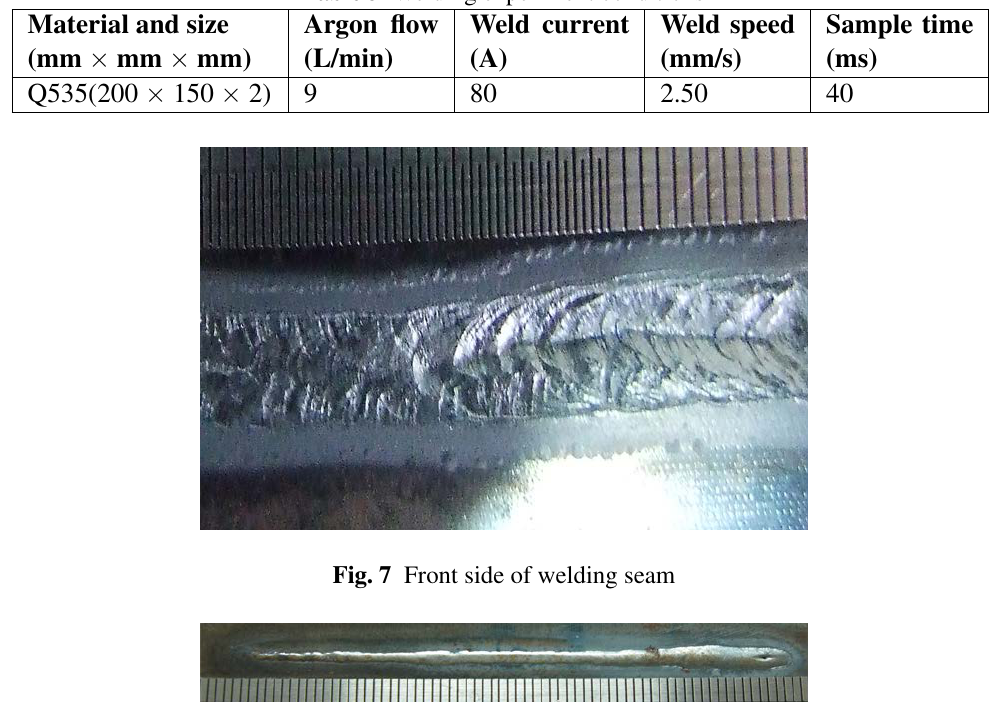
Fig. 8 Back side of welding seam